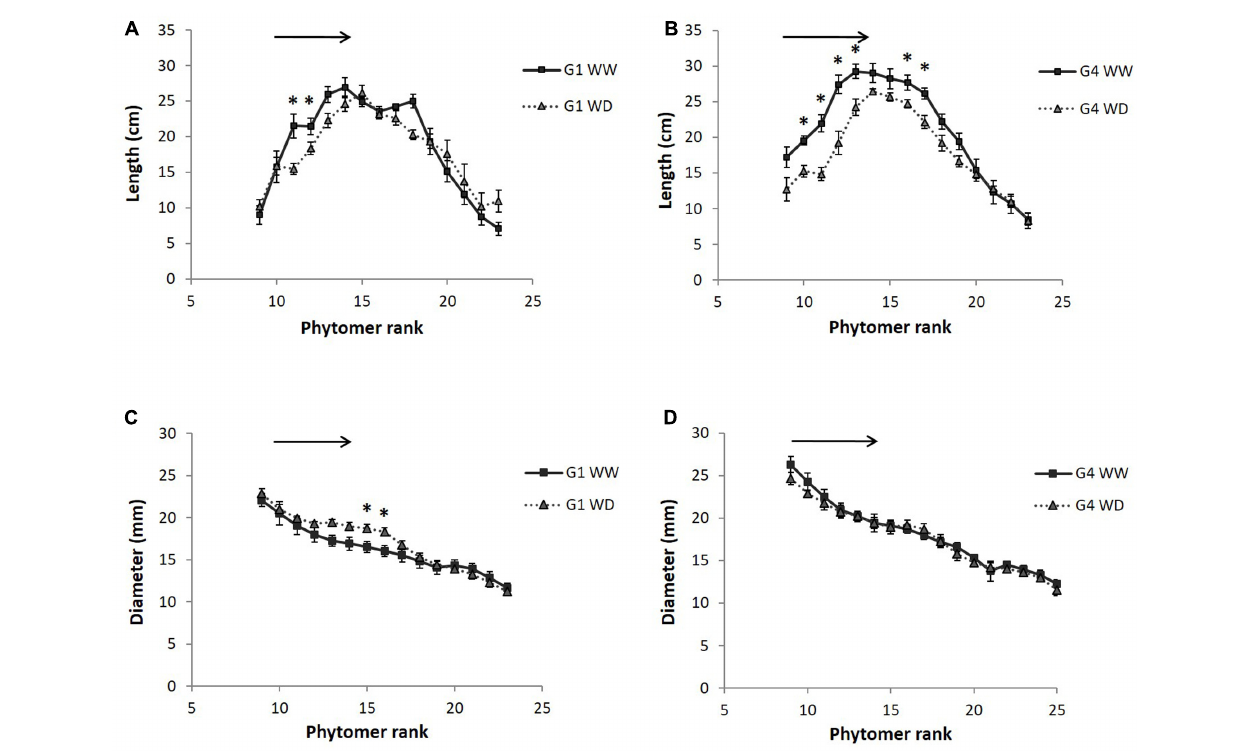
FIGURE 4 | Internode length (A,B) and diameter (C,D) as a function of their rank along the main stem, measured in 2014 field experiment on two hybrids (G1: Biomass140, G4: RE1xAR4) and for two water conditions (WW: well-watered, WD: 1 month of water deficit during stem elongation). Each point on the curve is a mean of 12 internodes with standard error bars. The black arrows indicate internodes having grown during the water deficit period and the black stars internode ranks with significant treatment effects evaluated by ANOVA ( p -value <